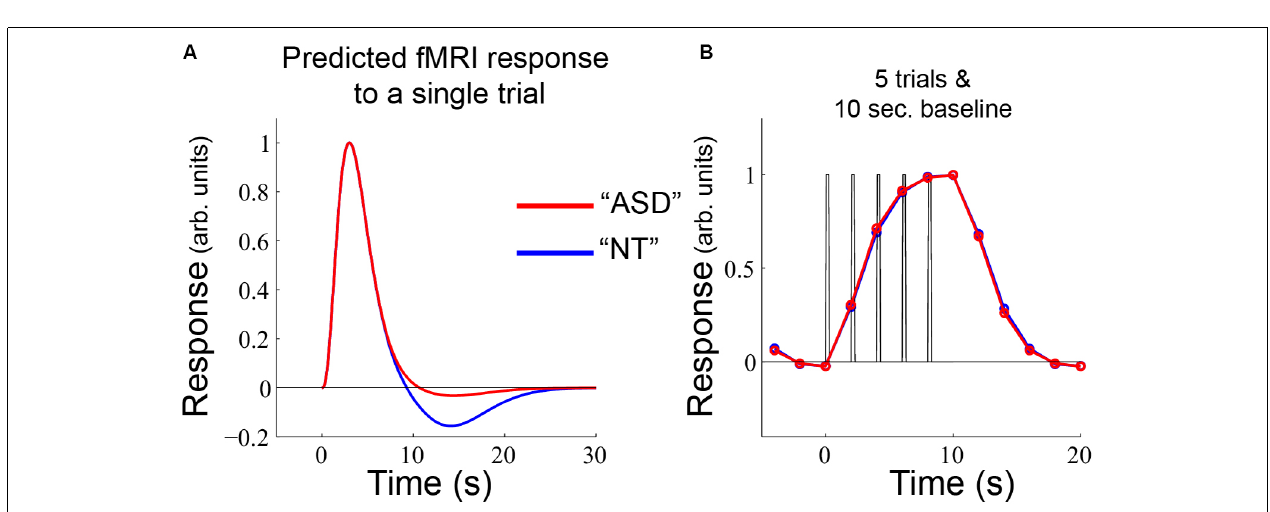
FIGURE 7 | (A) The same single-trial model as used in Figure 6 was applied to (B) an alternative experimental design, which yields nearly identical predicted fMRI timecourses for NT and